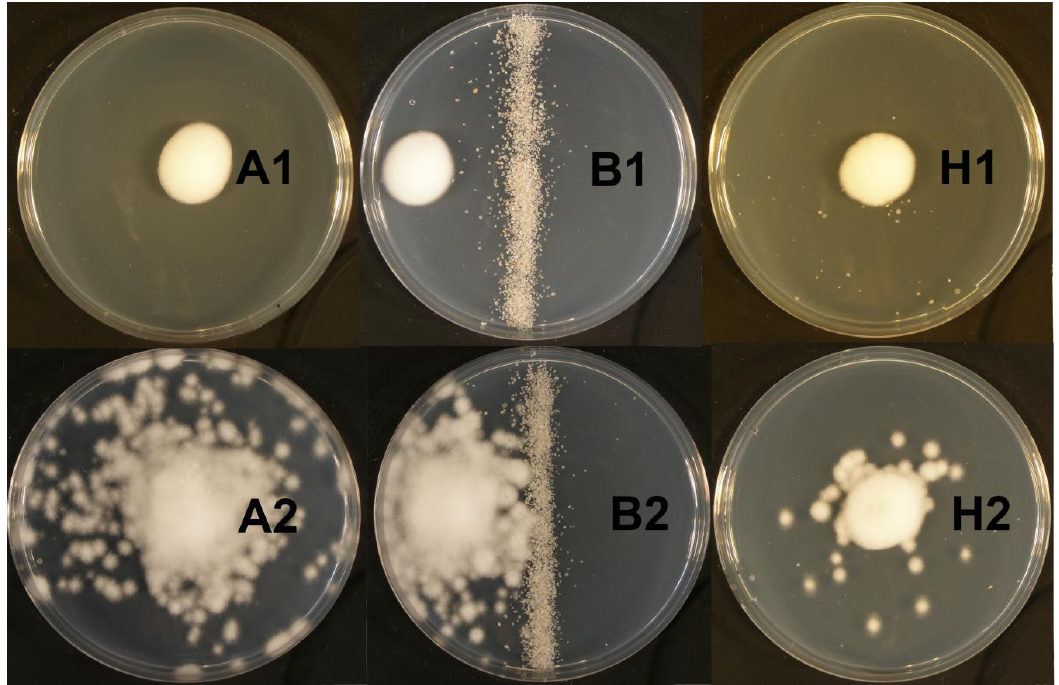
Figure 4. Examples of dissemination of the blastospores of Isaria fumosorosea by Heterorhabditis bacteriophora on clean PDA plates ( A ), plates with a line of silver sand as a barrier ( B ), and a sand heap ( H ). Replications were performed without nematodes ( A1 , B1 , H1 ) and with ensheathed infective juveniles ( A2 , B2 , H2 ). The other combinations of nematodes, spores and experimental arena type are not shown as they seem very similar. This is an illustrative photo that do not have fully correspond with data presented in Figure 3 that shows means and standard deviations.